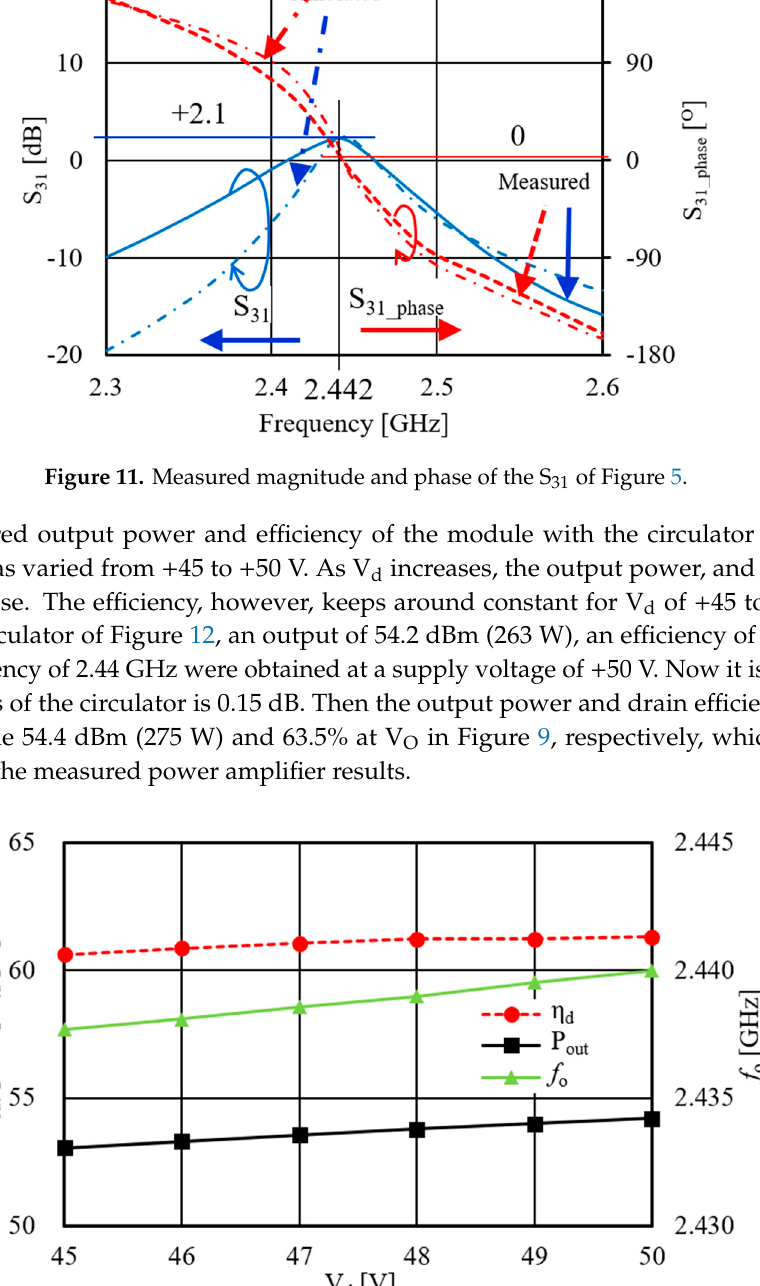
Figure 10. Measured output power and efficiency of the power amplifier.